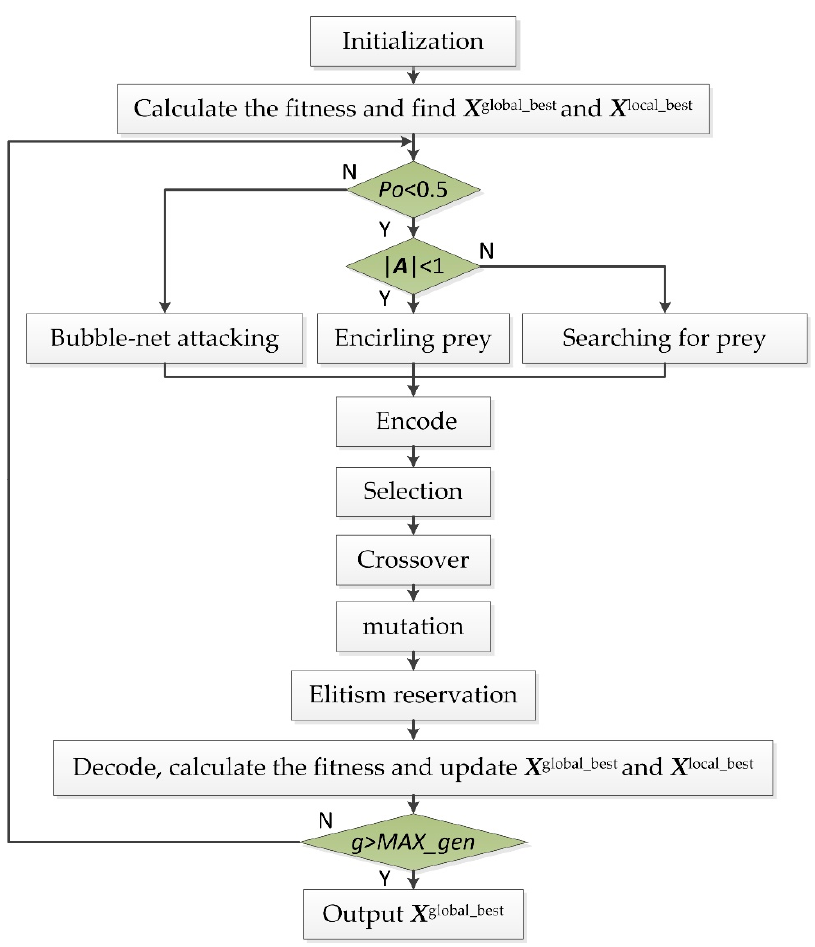
Figure 1. Flowchart of the WOA-GA optimization algorithm.